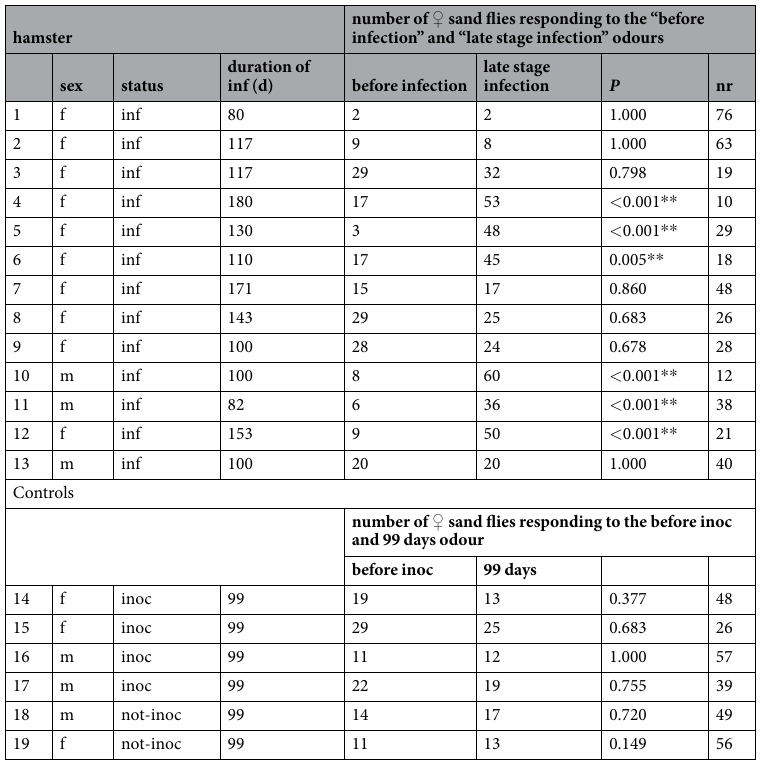
Table 1. The number of female sand flies responding to late stage infection odour hamsters and before infection odour in a Y-tube olfactometer, nr = no response (the number of female sand flies that did not respond after 3 mins). The numbers responding to each side of the olfactometer were compared for each hamster using a 1-proportion exact test ( * P < 0.05, ** P < 0.01). The Control section of the table includes female sand fly responses to sham inoculated (inoc) or not inoculated (not-inoc) hamsters. The sex of the hamster (m/f) and the length of time for infection to reach the late stage of infection (duration of inf. days) are